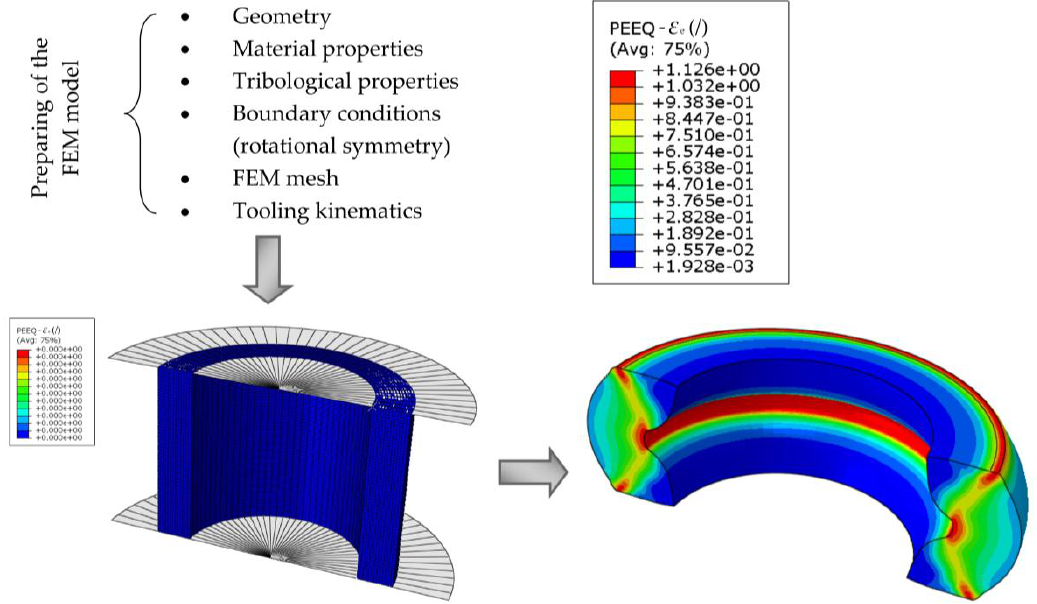
Figure 2. Rotational-symmetric FEM model of the tube ( left ) in a 3D-view and the results of the equivalent strain distribution obtained by a FEM simulation in a 3D-view ( right ).